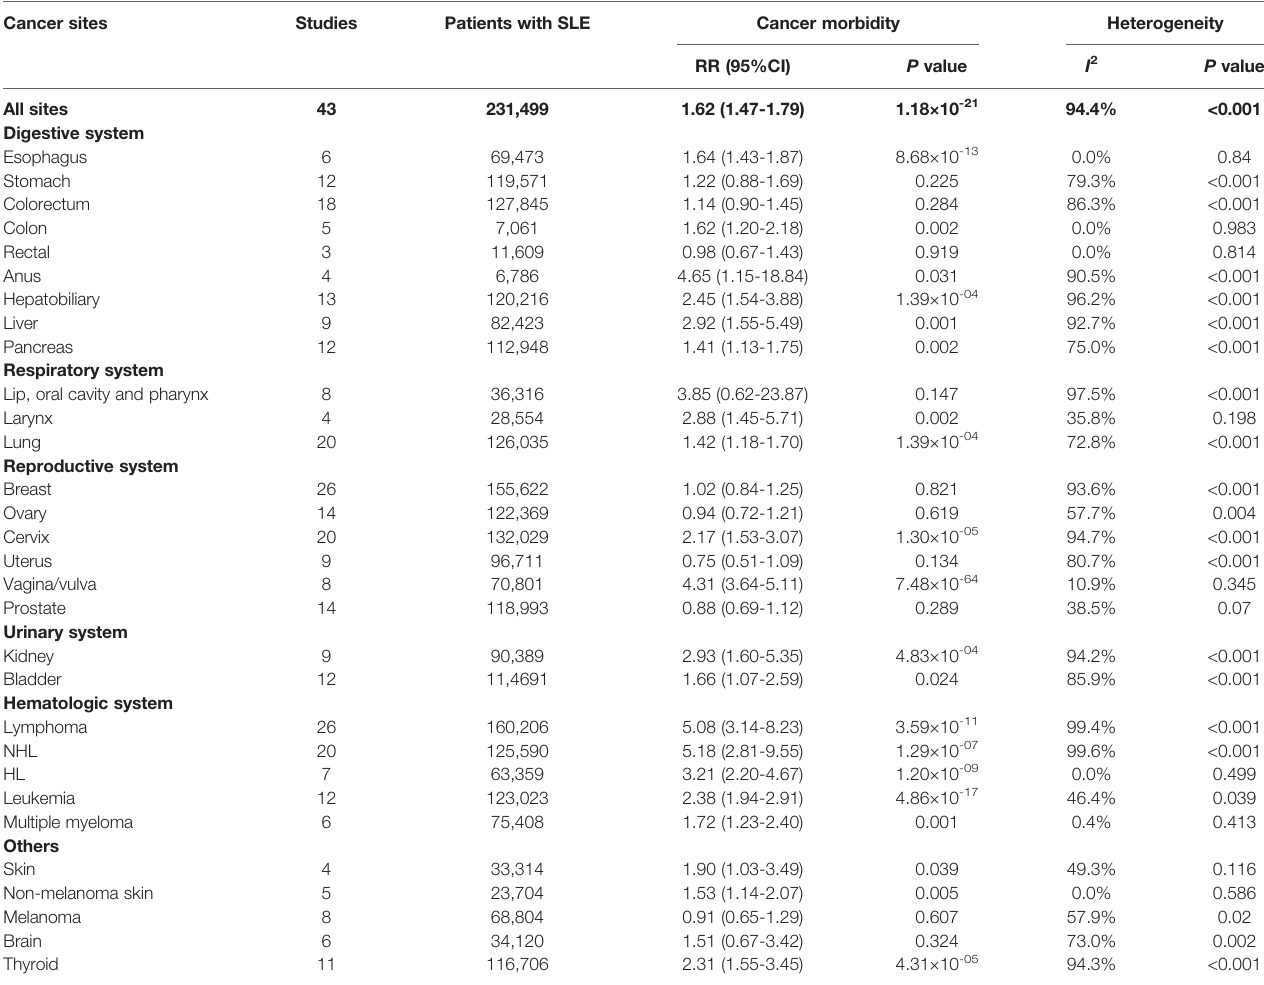
TABLE 1 | Meta-analysis of the association between systemic lupus erythematosus and cancer risk. Cancer sites Studies Patients with